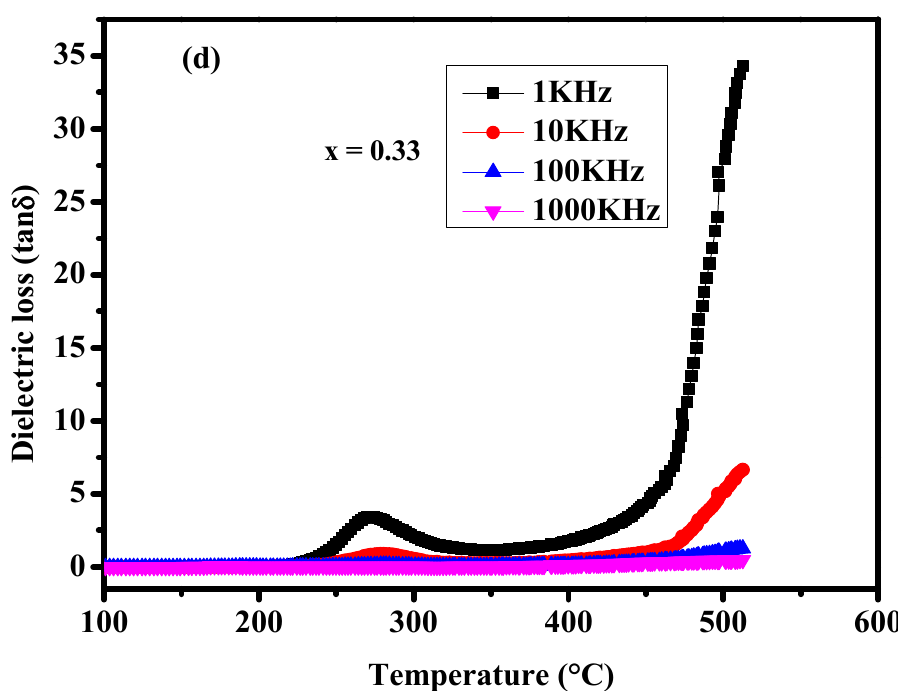
Figure 5. ( a – d ) Evolution in dielectric loss with respect to temperature is plotted for the prepared ceramics.